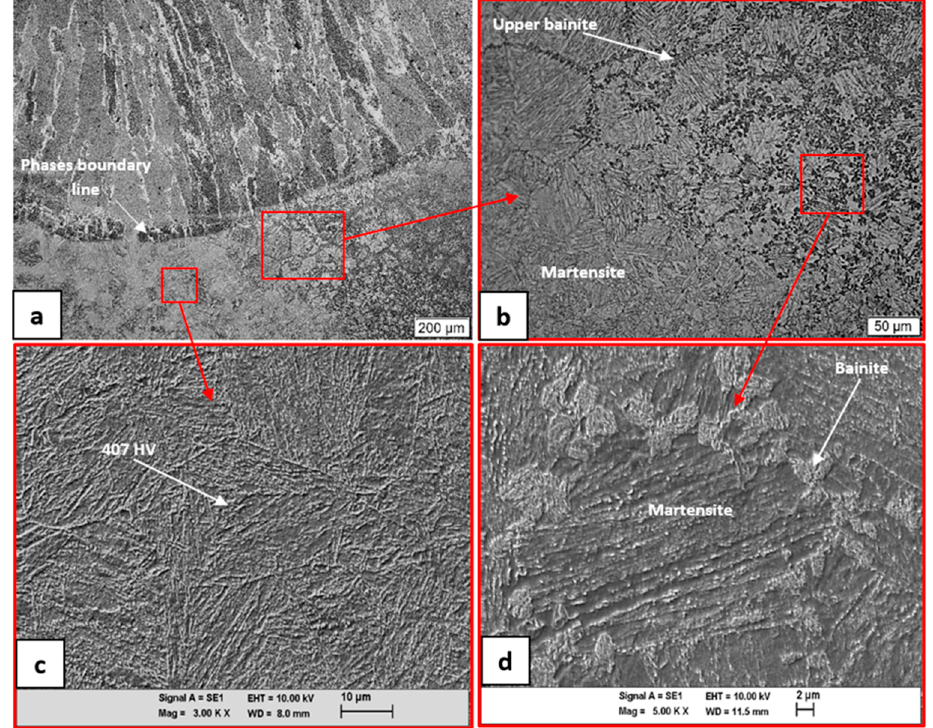
Figure 10. ( a ) Phase transition of the banded structure; ( b ) martensite with some colonies of upper bainite; ( c ) martensite microstructure; ( d ) detail of ( b ). After the phase boundary line in region 4, bainite colonies disappeared and give way to only martensite phase (Figure 11a,b). Region 5 comprises the microstructure around the shaft core, which consists of ferrite–acicular (light gray) and pearlite (dark) (Figure 11c,d); the pearlite is dispersed in the boundaries of the grains and as plates within the ferrite matrix. The structure presented a microhardness of 247 ± 11 HV, which is a normal value for a shaft core for this type of